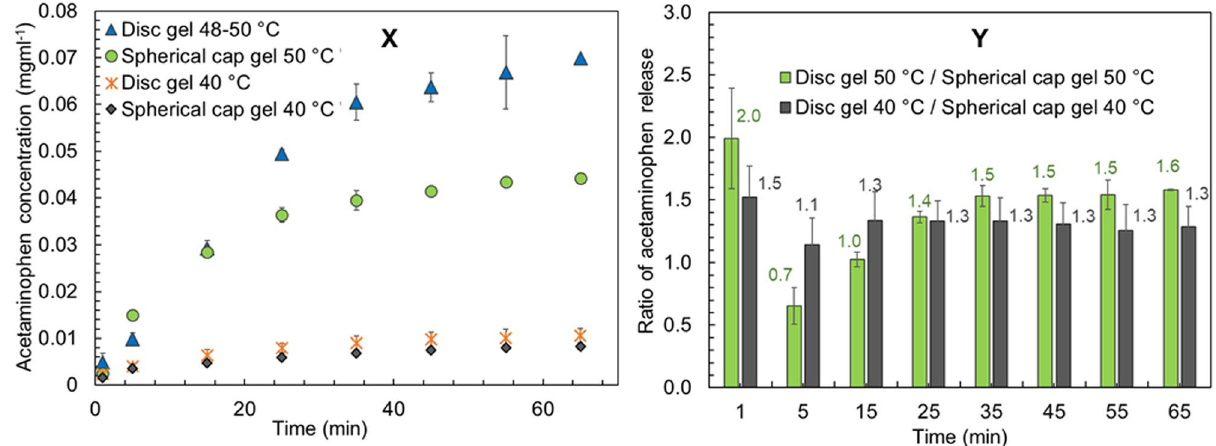
Figure 4. Results for acetaminophen (Ac) release with time from disc shaped vs spherical cap shaped gels. ( X ) Comparison of Ac release concentrations from disc and spherical cap shaped gels at 40 and 50 °C. ( Y ) Ratio of Ac released from disc and spherical cap shaped gels at 40 and 50 °C (note: for disc shaped gels an average of 48–50 °C results were used for graph Y